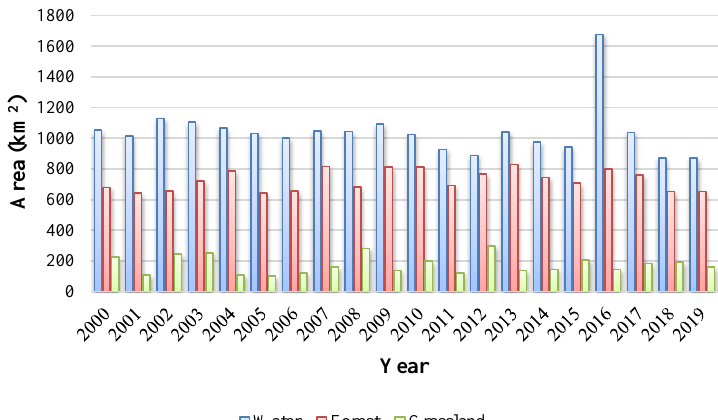
Figure 7. Natural habitat change.